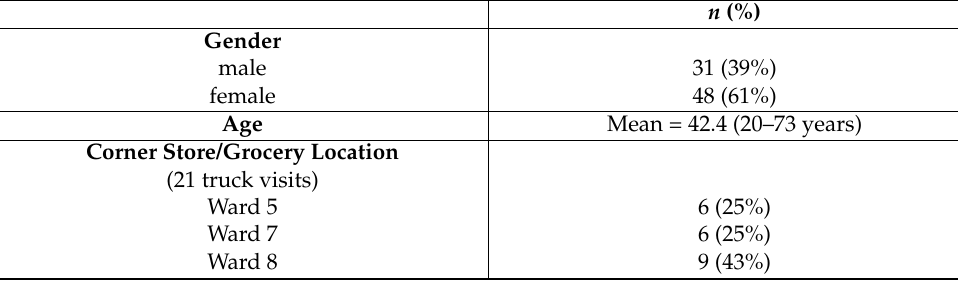
Table 2. Participant Characteristics ( n =